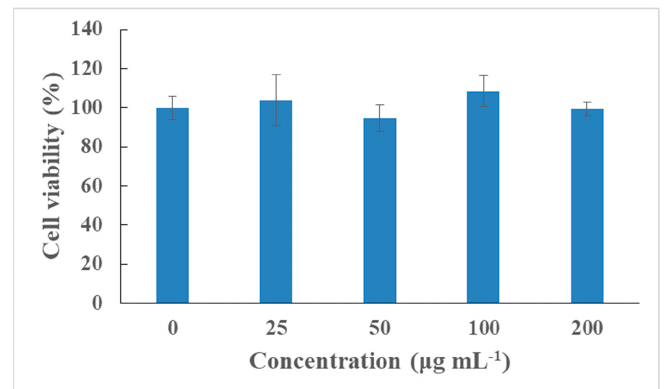
Figure 6. Relative viabilities of PC-3 cells after incubation with various concentrations of Ce6-P/W NE nanodroplets for 24 h. The Ce6 concentrations are 0, 0.5, 1, 2, and 4 μ g/mL. Data were presented as mean value ± standard deviation. After Levene’s test for equality of variances, one-way analysis of variance (ANOVA) and Bonferroni multiple comparison test was employed for the comparison of mean values. n = 3. Ce6-P / W NE, chlorin e6-perfluoropolyether (PFPE) / water